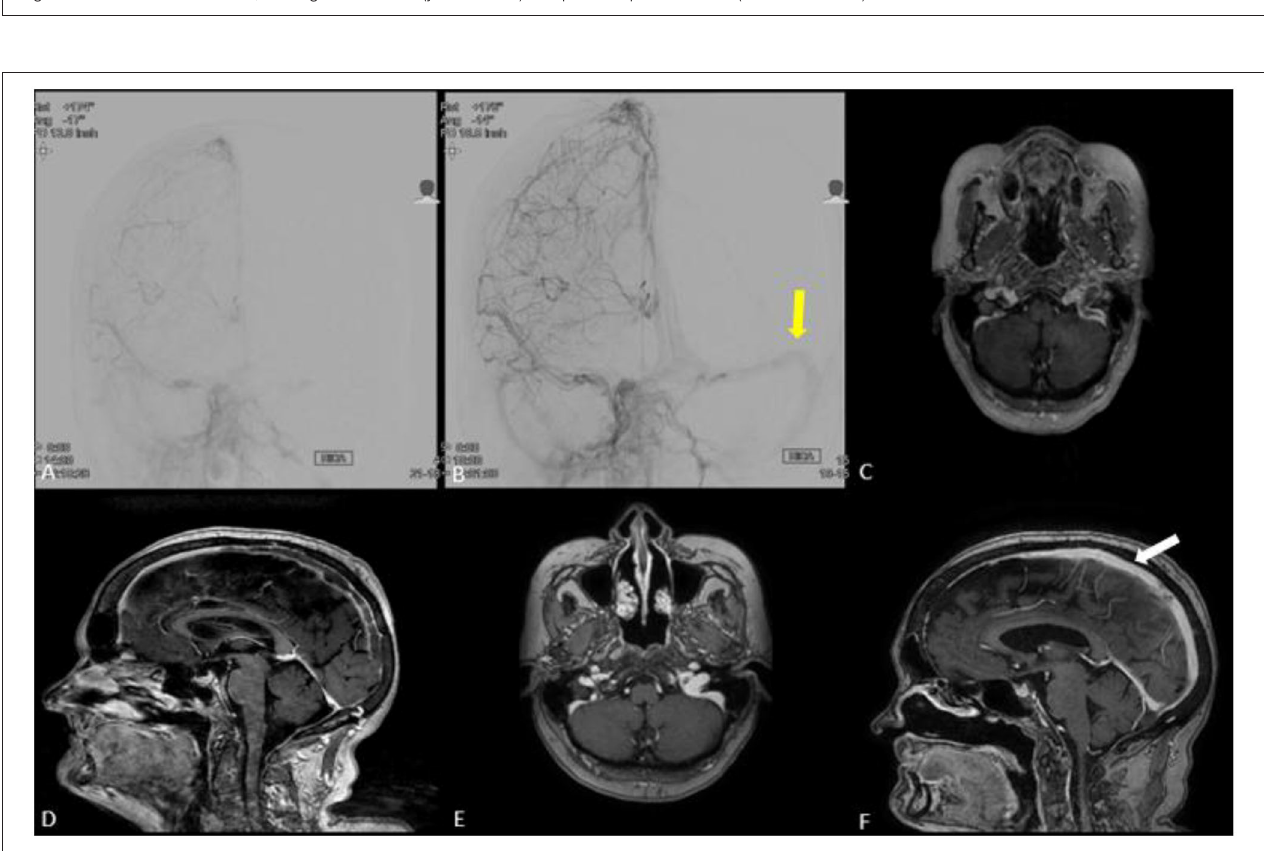
FIGURE 4 | (A,B) Anteroposterior cerebral angiogram run in (B) is post treatment demonstrating partial recanalization of posterior aspect of superior sagittal sinus and left transverse/sigmoid complex (yellow arrow) compared to pre-treatment (A) . (C–F) MRI brain with and without contrast in axial (E) and coronal views (F) demonstrating near complete recanalization of superior sagittal sinus (white arrow) and left transverse/sigmoid complex at 3 months clinic follow-up compared to MRI brain obtained prior to venous thrombectomy (C,D) .